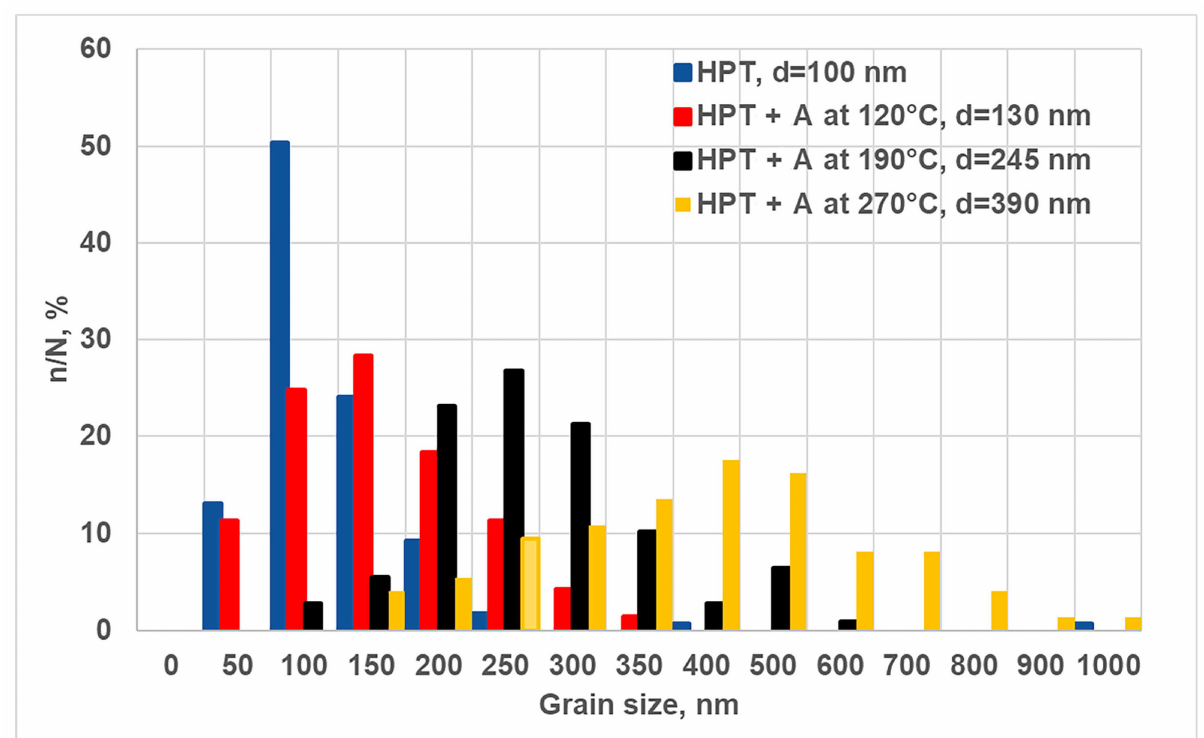
Figure 3. Grain size distributions after HPT and annealing at temperatures of 120, 190 and 270 ◦